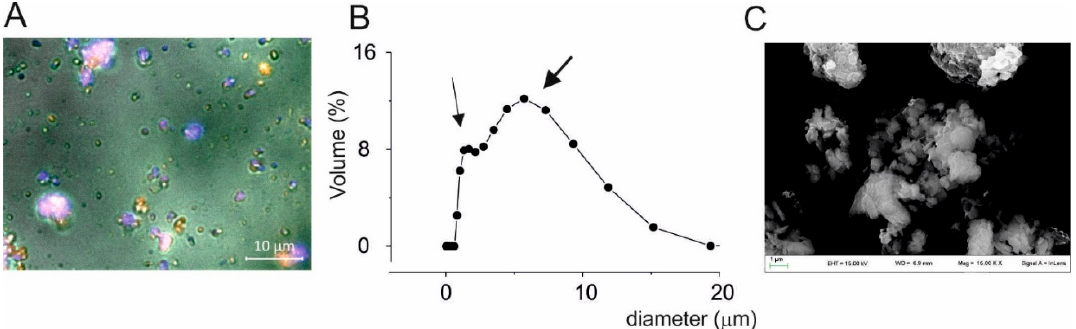
Figure 2. Properties of Resv@MDH dry powder. ( A ) Image created by digital merging of bright-field and DAPI/Rhodamine fluorescence illumination. ( B ) Granulometric analysis of Resv@MDH dry powder. ( C ) SEM image of Resv@MDH dry powder.